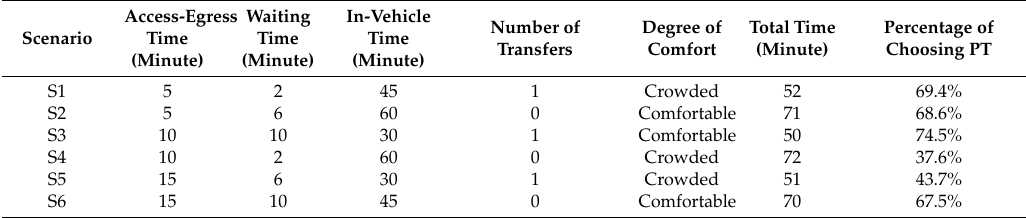
Table 10. Service level comparison of di ff erent scenarios.